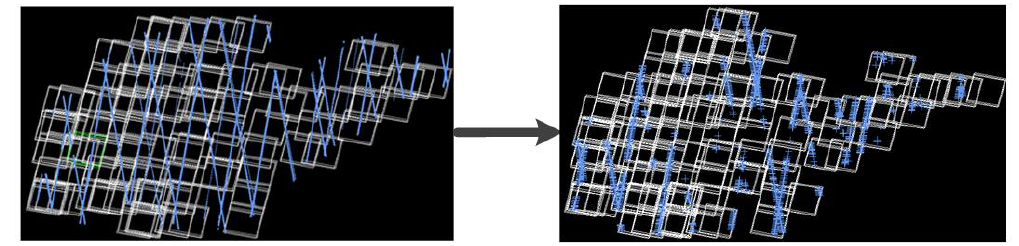
Figure 4. Result map of laser elevation control points in experimental area after screening